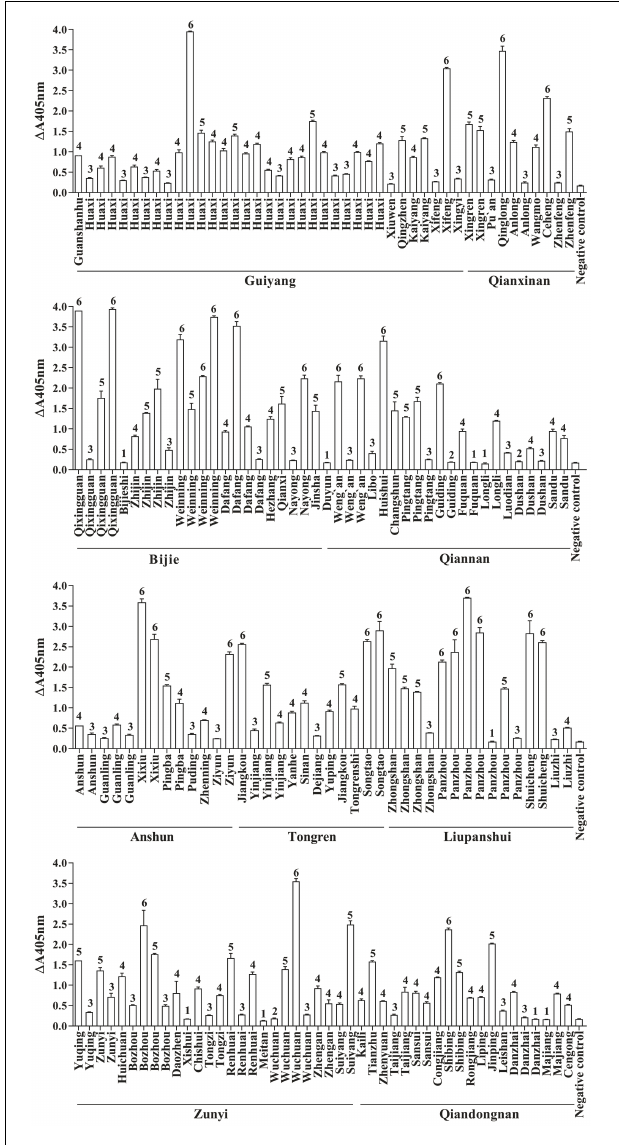
FIGURE 1 | Fusarium infections in maize samples detected by rapid immunoassay. 1: n < 1.5, samples without Fusarium infections; 2: 1.5 ≤ n < 2, suspected infection samples; 3: 2 ≤ n < 10, mild infection samples; 4: 10 ≤ n < 30, moderate infection samples; 5: 30 ≤ n < 50, severe infection samples; 6: n ≥ 50, extreme infection samples; n = (OD 405 nm value of sample–OD 405 nm value of blank control)/(OD 405 nm value of negative control–OD 405 nm value of blank